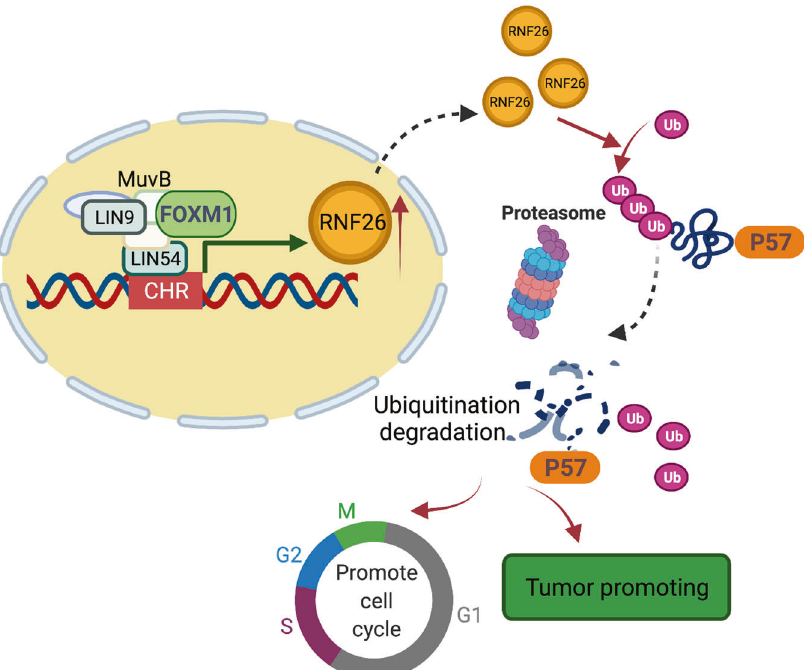
Fig. 7 A hypothesis model depicted that the abnormal expressed FOXM1 bound to the promoter of RNF26 and initiated the transcription of RNF26 through MuvB complex in the bladder cancer cells. The upregulated RNF26 interacted with p57 to degrade p57 and enhance the progression of bladder cancer